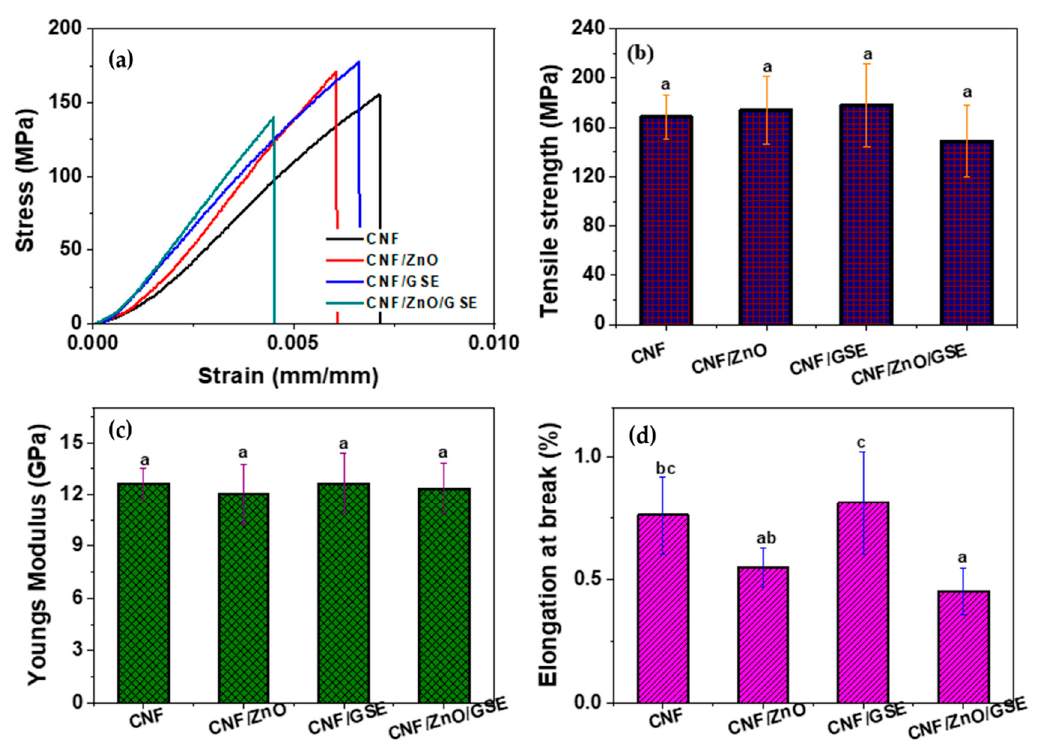
Figure 6. Mechanical properties of CNF/ZnO/GSE films: ( a ) stress–strain curves, ( b ) tensile strength, ( c ) Young’s modulus, ( d ) elongation at break. Data with the same superscript letter within the same column are not significantly ( p > 0.05) different from Duncan’s multiple range tests.